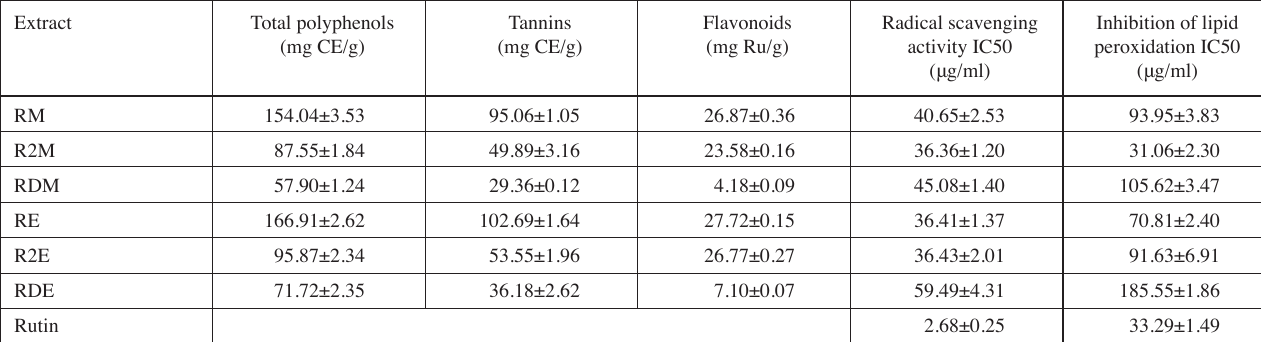
Tab. 1: Phenolic contents of rue extracts and IC50 values of Ruta graveolens extracts and rutin in antioxidant